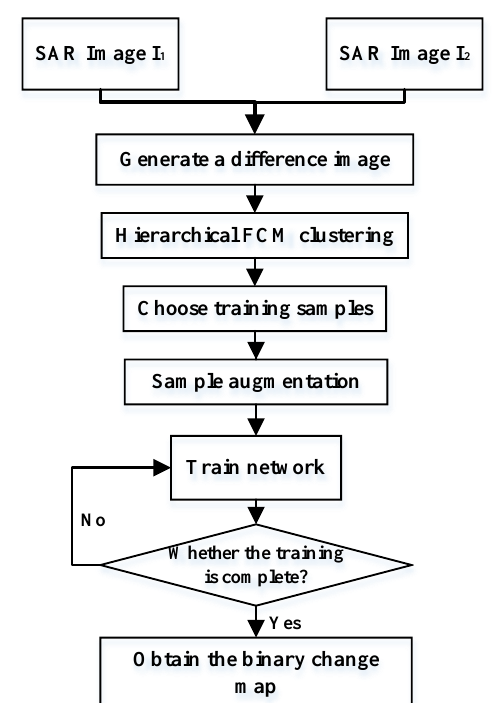
Figure 1. The flowchart of SAR change detection based on deep